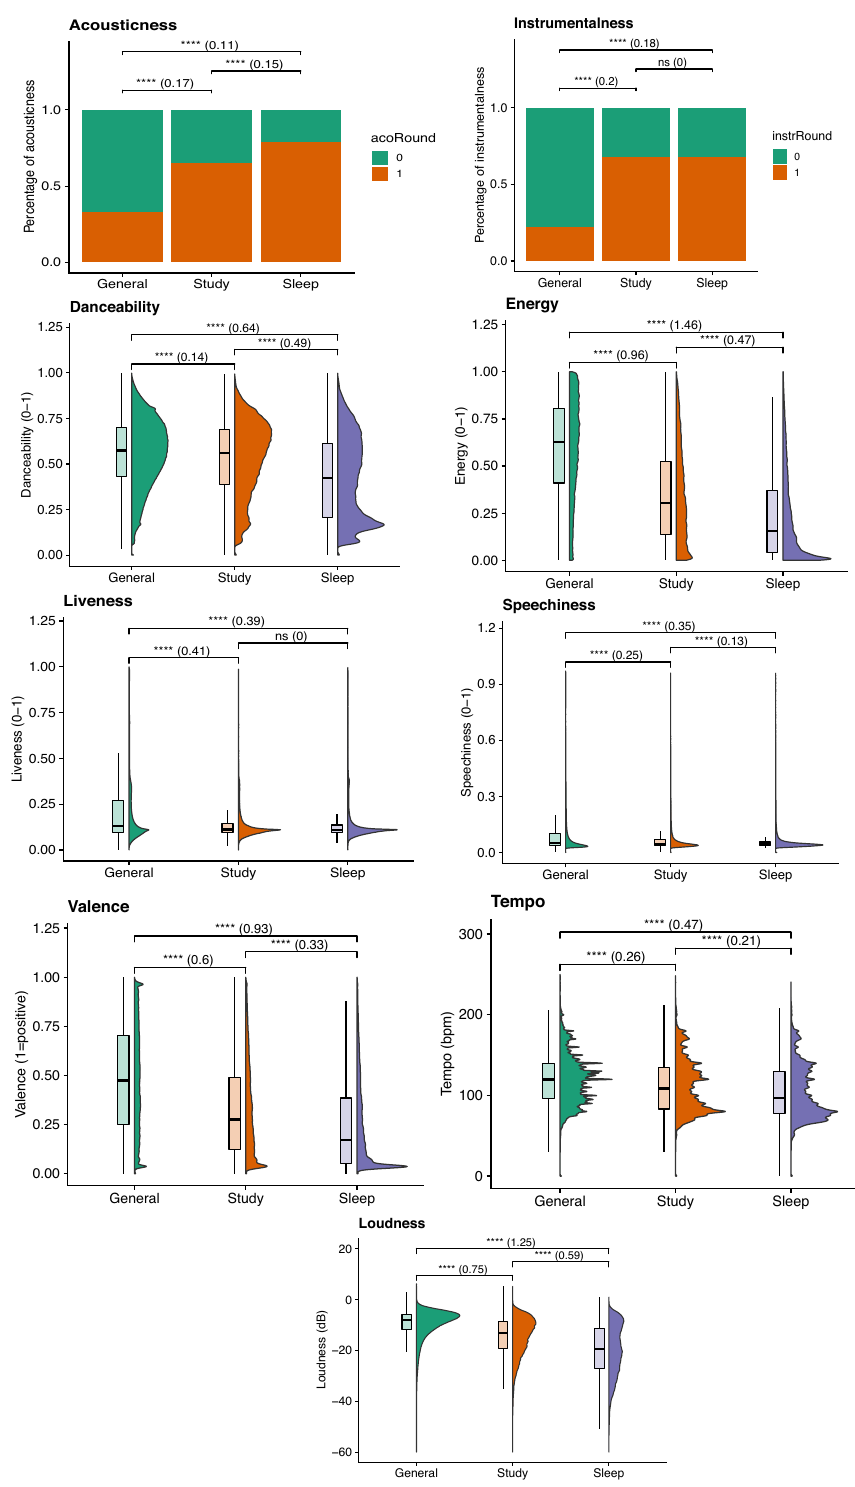
Figure 3. Density plots, t-test significance asterisks and Cramer’s V statistic in brackets between each pair of datasets for each audio feature for all audio features except for Acousticness and Instrumentalness where a chi- squared test was used. ****, p < 0.001 Bonferroni